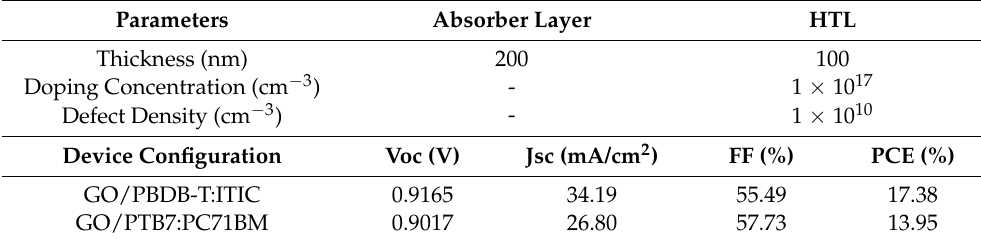
Table 5. Optimized numerical parameters and performance